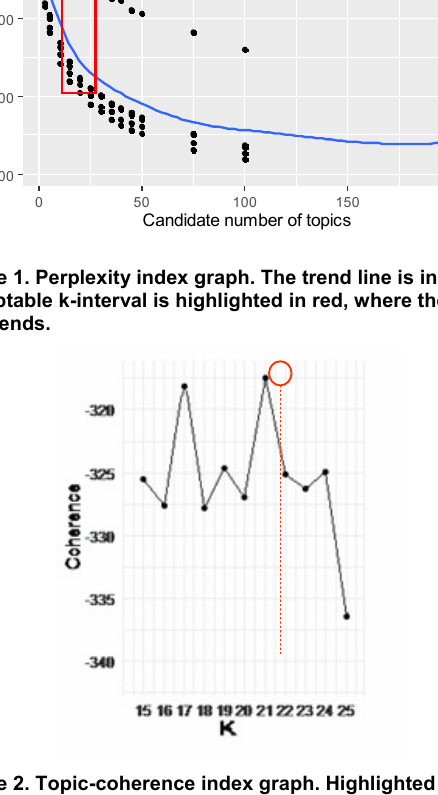
Figure 2. Topic-coherence index graph. Highlighted in red is the value of k = 21 that has the highest